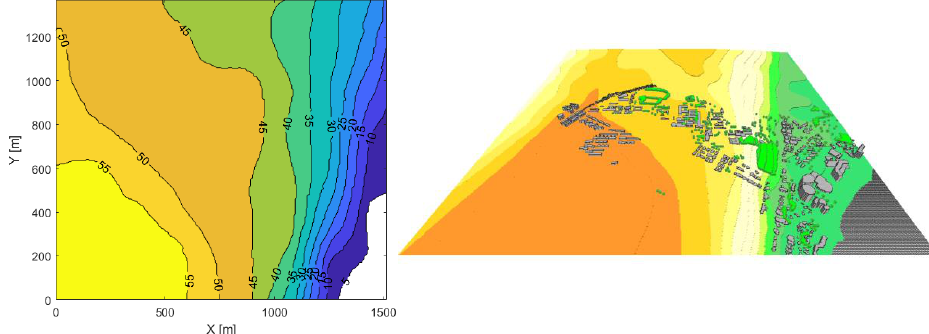
Figure 8. On the left: terrain elevation (m above the mean sea level) employed in the ENVI-met simulations; on the right: a view of the 3D model employed for the preliminary simulation on a larger scale.